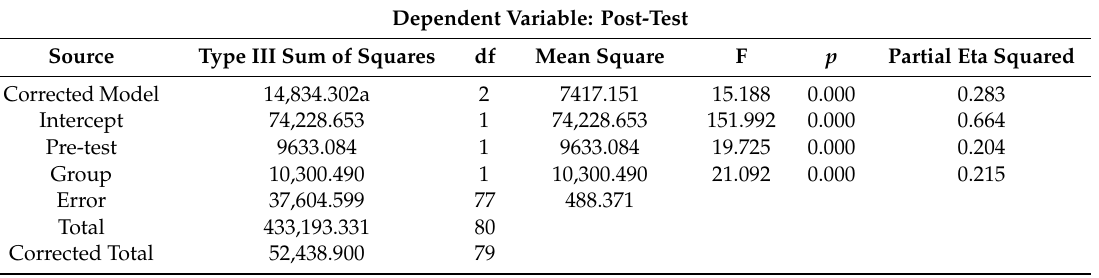
Table 7. Tests of Between-Subjects E ff